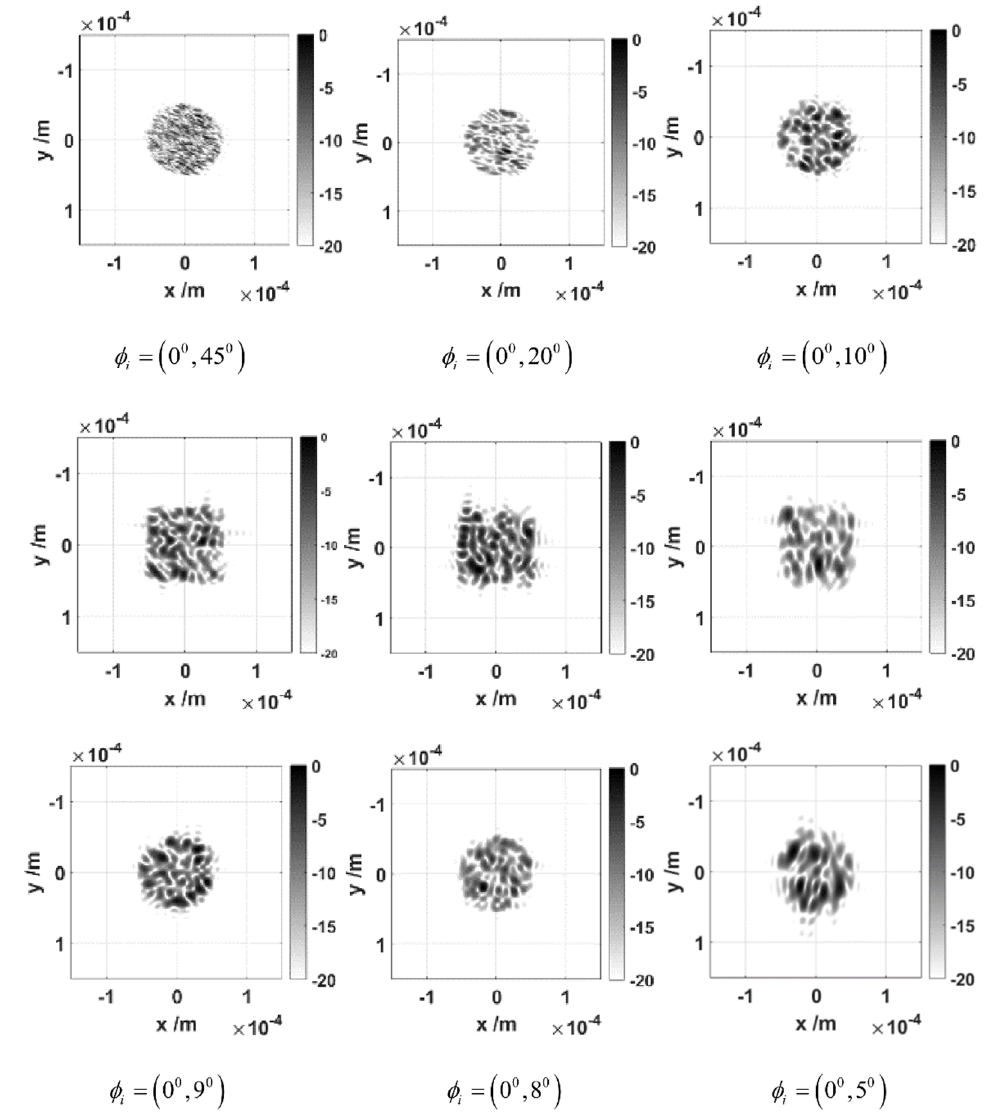
Figure 2. Effect of rotation angle on ISAL image of rough square plate and rough circular